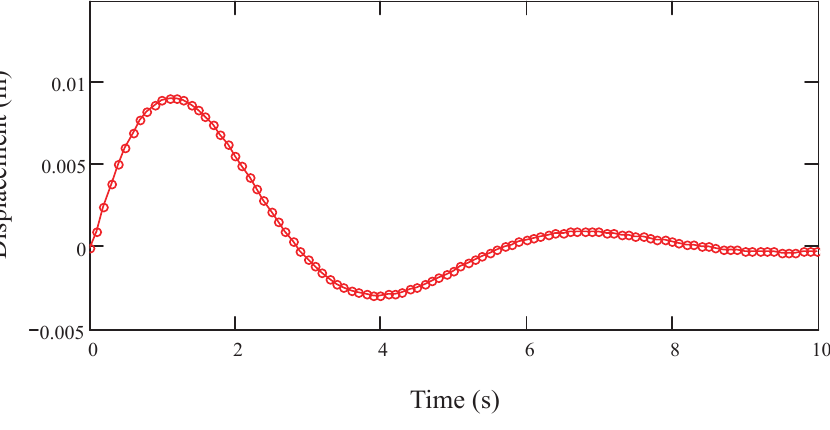
Fig. 8. Impulse response of SDOF